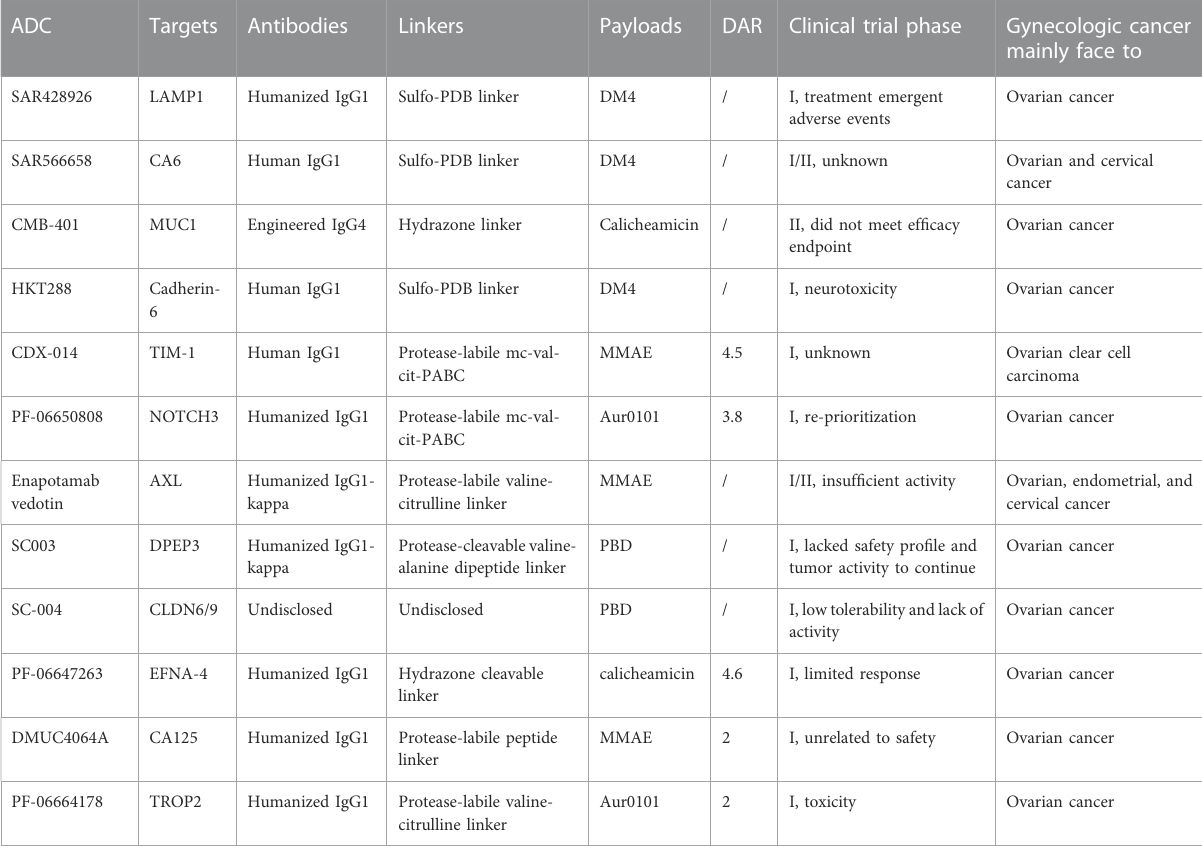
TABLE 4 Discontinued ADCs in gynecologic